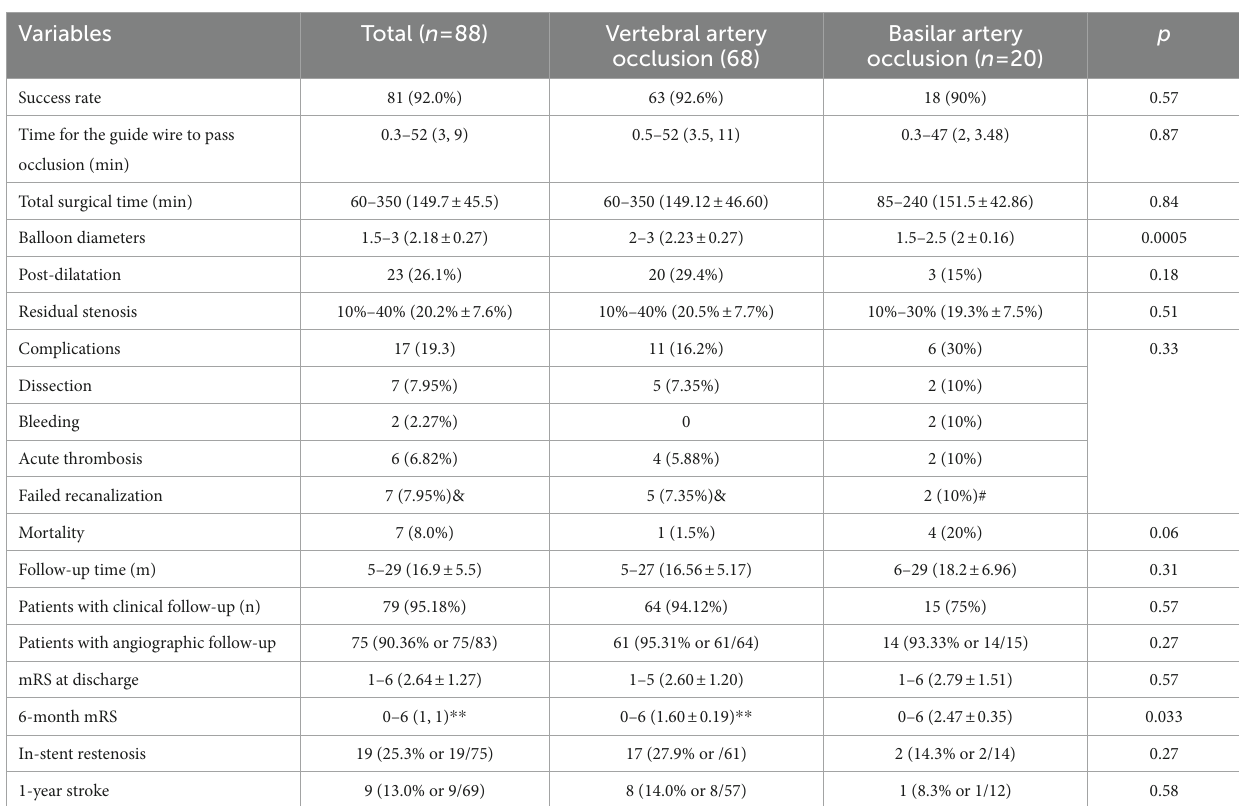
TABLE 2 Data of endovascular